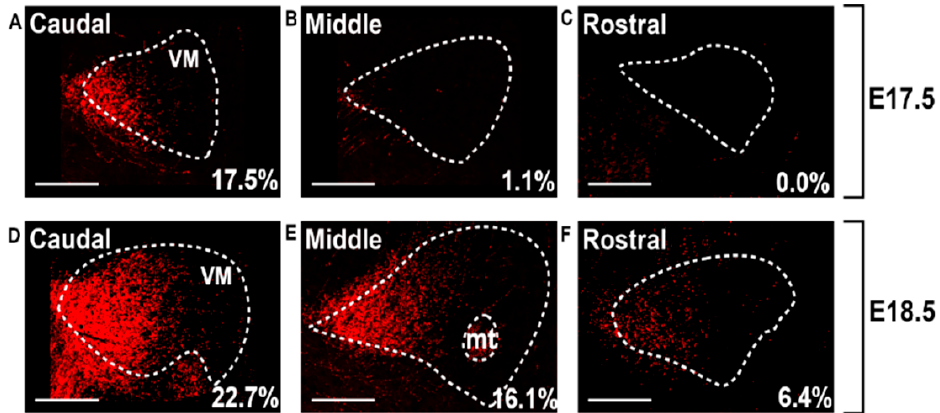
Figure 8. RFP + fibers in embryonic thalamus of Ntsr1-Cre/AI14 mice progress rostral through the ventromedial nucleus. At three rostrocaudal levels the percentage of summed area occupied by above-threshold RFP-signal (pSAO) is reported for E17.5 ( A – C ) and E18.5 ( D – F ). Note that the indicated percentages are not equal to those reported in Figures 9 and 10, since the latter represent the averages from bilateral VM of several sections. Table 5. pSAO values (in %) of the investigated thalamic nuclei and the Z- and p -values of the dif- ferences between the age groups of each of these nuclei. Šidák-corrected p -values of 0.0127 were used for all nuclei, except VL for which a Šidák-corrected p -value of 0.017 was chosen. Significant differences are indicated in bold letters. For VB there was no post hoc test since the Kruskal–Wallis analyses showed no significant difference. E16.5